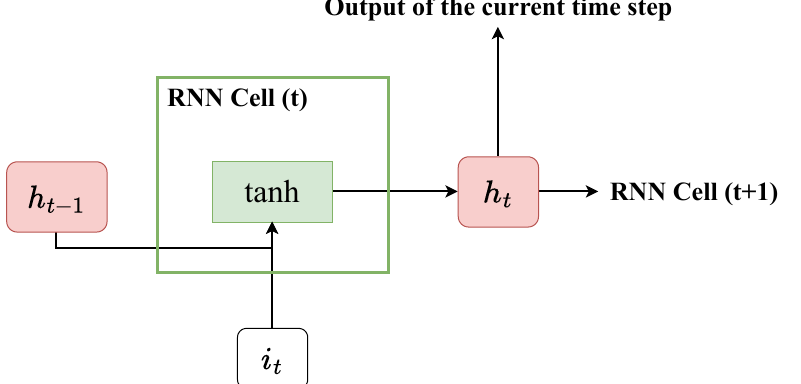
Figure 5. Schematic of a basic RNN model.